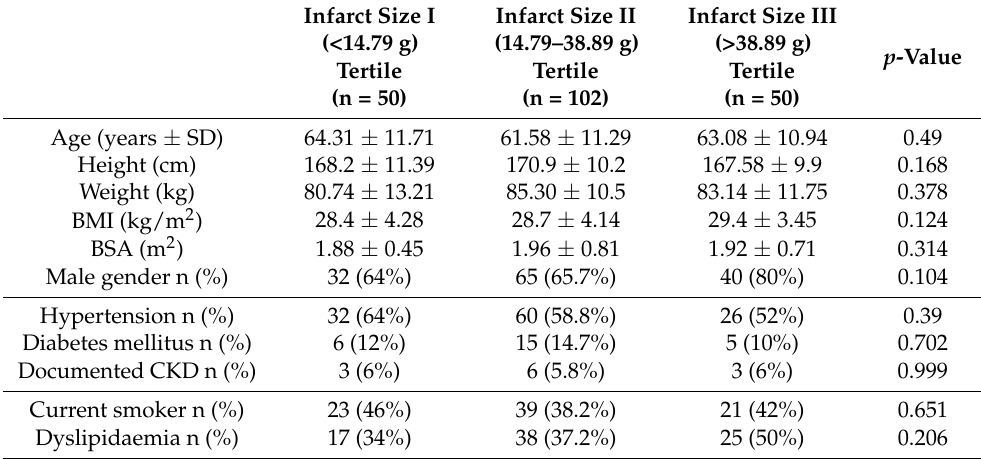
Table 1. Demographic information, medical history, and risk factors of the study